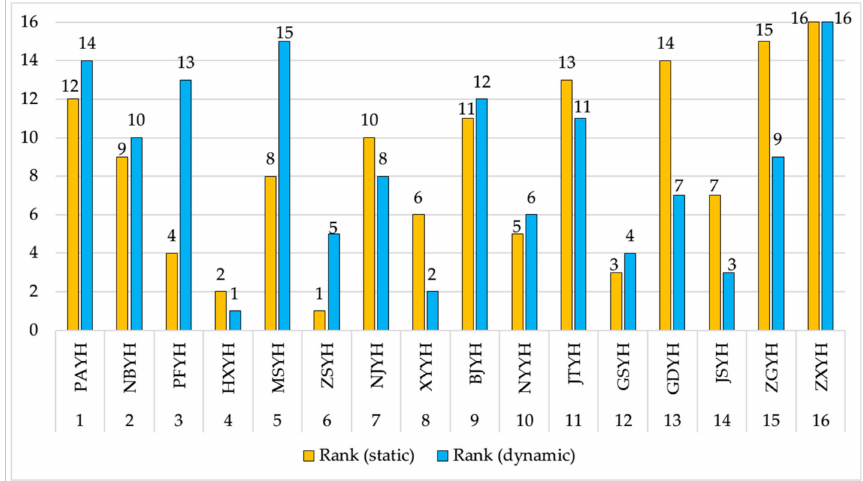
Figure 12. Comparison: measurements (The left axis refers to the rankings based on the overall results derived from two models) of static and dynamic ∆ CoVaR (In the figure, ∆ CoVaR refers to the di ff erence between the Conditional Value at Risk (CoVaRs) when the bank is in distress and in a normal